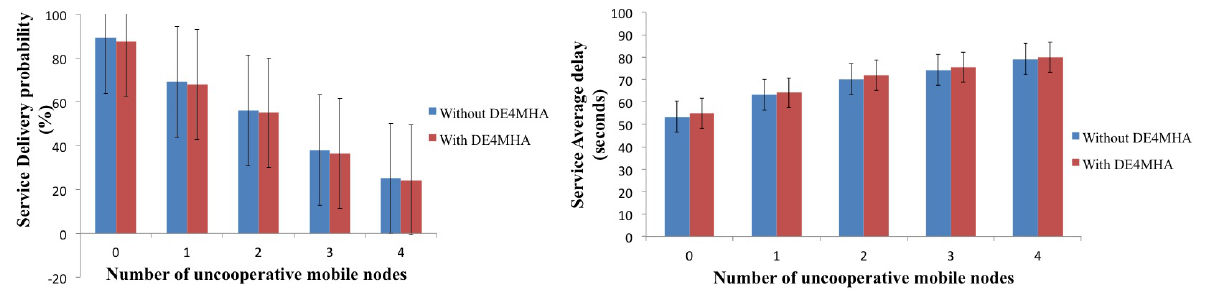
Figure 6. Service delivery probability and average service delay as a function of the number of uncooperative mobile nodes with and without the